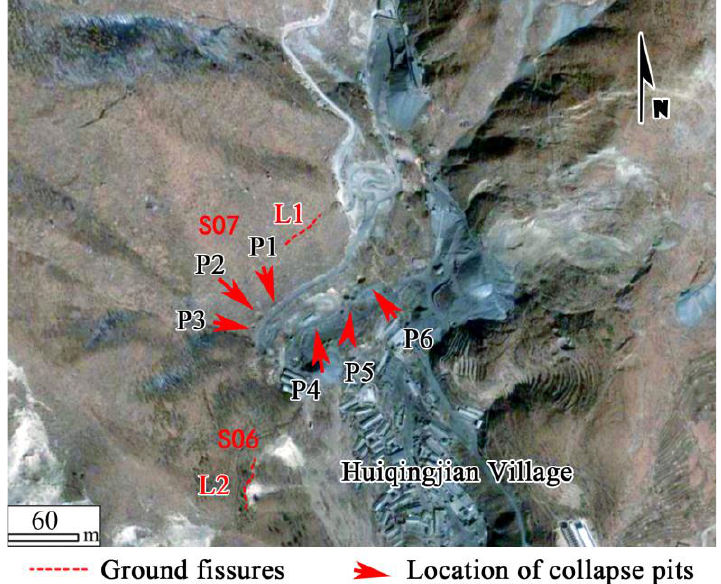
Figure 13. Optical image of landslides S06 and S07 in 2003. L1, L2 denotes ground fissures. P1, P2, P3, P4, P5 and P6 denote collapsed pits.